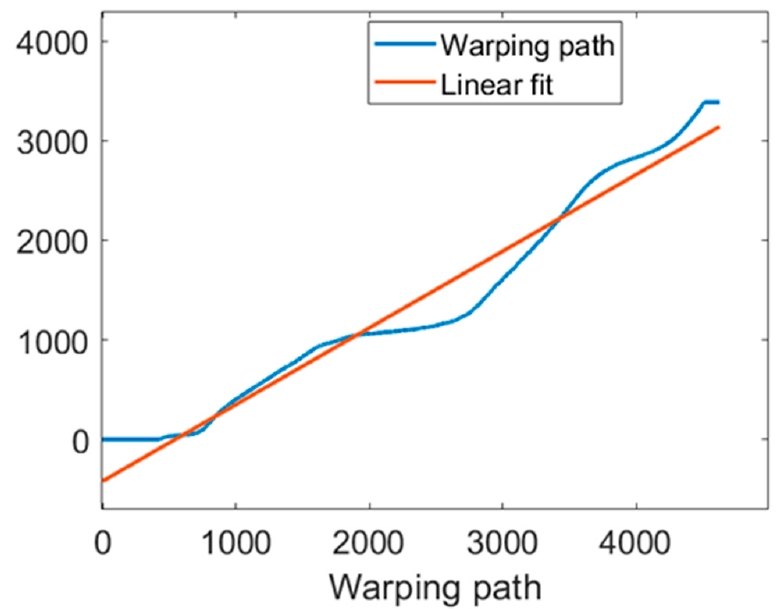
Figure 14. Curve-matching relation between 1# and 5#.